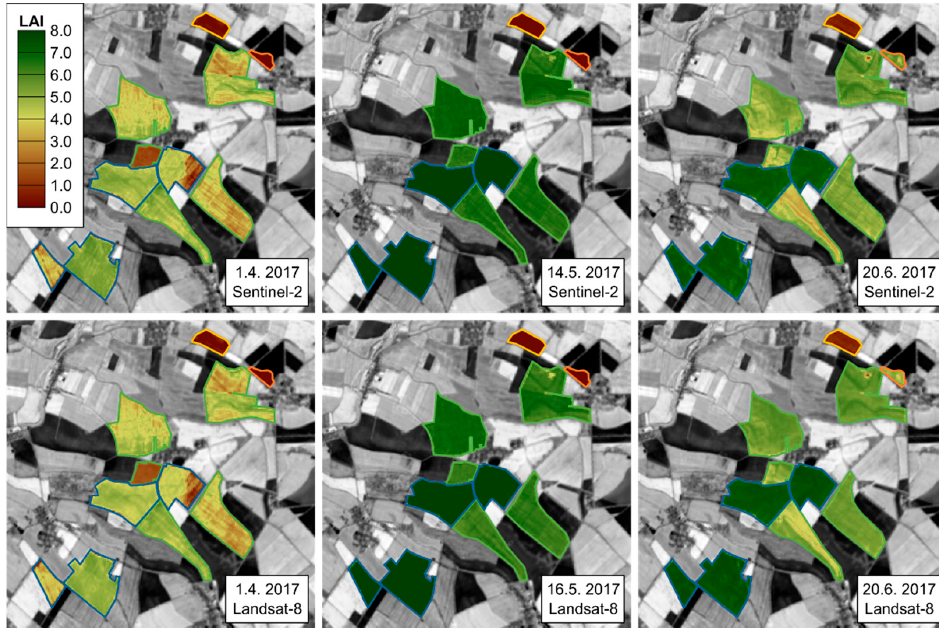
Figure 6. Examples of Landsat 8 and Sentinel-2 LAI layer pairs derived from the near acquisition date images. Plot borders are drawn in color according to crop type. Winter wheat (green), winter rapeseed (blue), sugar beetroot (orange), and corn (yellow) grow on the plots shown.